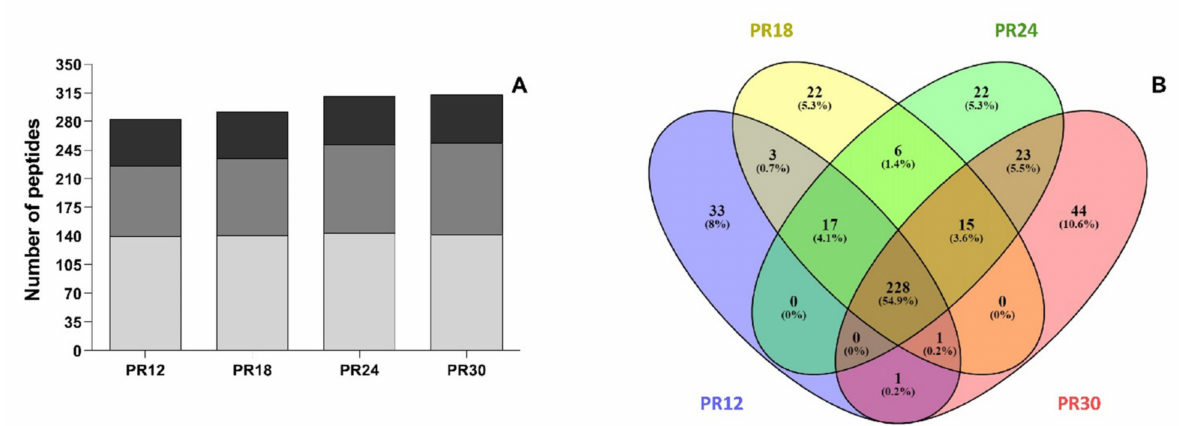
Figure 3. Number of peptides identified in the Parmigiano-Reggiano (PR) peptide fractions. ( A ) Number of peptides identified in the PR water-soluble peptide extracts at 12 (PR12), 18 (PR18), 24 (PR24), and 30 (PR30) months of ripening. The incidence of the different milk proteins on the released peptides is also shown. Gray identified the number of peptides released from β -casein. Dark gray identified the number of peptides released from α S1-casein. Black identified the number of peptides released from α S2-casein. ( B ) Venn diagram created with all the identified peptides in PR water-soluble peptide extracts at 12, 18, 24, and 30 months of ripening (see online Supplementary Material Table S1 for the peptide